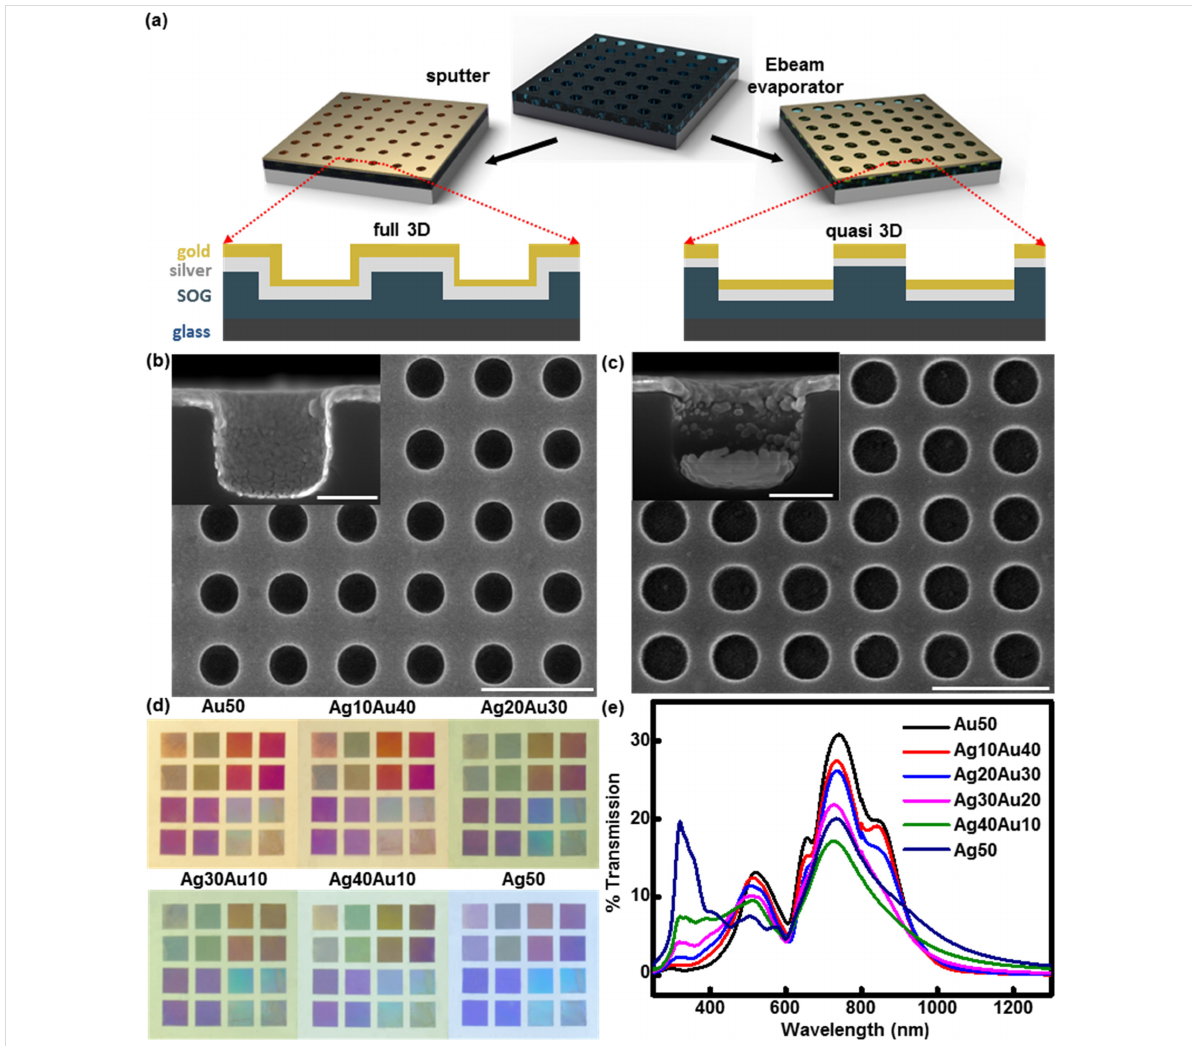
Figure 1: (a) 3D and 2D schematic illustration of the full-3D and quasi-3D plasmonic crystals (PCs). To fabricate the metal films, sputtering was used for the full-3D PC and e-beam evaporating was used for the quasi-3D PC. SEM images of a (b) full-3D and (c) quasi-3D PC with diameters and peri- odicities of ≈ 380 and 580 nm. The scale bar corresponds to 5 μ m. Inset: cross-sectional SEM image of an individual nanohole. The scale bar corre- sponds to 100 nm. (d) Optical images of embossed PCs with different metal layer compositions: ≈ 50 nm Au (Au50), ≈ 10 nm Ag/ ≈ 40 nm Au (Ag10Au40), ≈ 20 nm Ag/ ≈ 30 nm Au (Ag20Au30), ≈ 30 nm Ag/ ≈ 20 nm Au (Ag30Au20), ≈ 40 nm Ag/ ≈ 10 nm Au (Ag40Au10), ≈ 50 nm Ag (Ag50). The hole depth is ≈ 340 nm and the hole spacing varies from ≈ 500 nm to ≈ 1740 nm. (e) Normal incident transmission spectra of five full-3D PCs with differ- ent metal